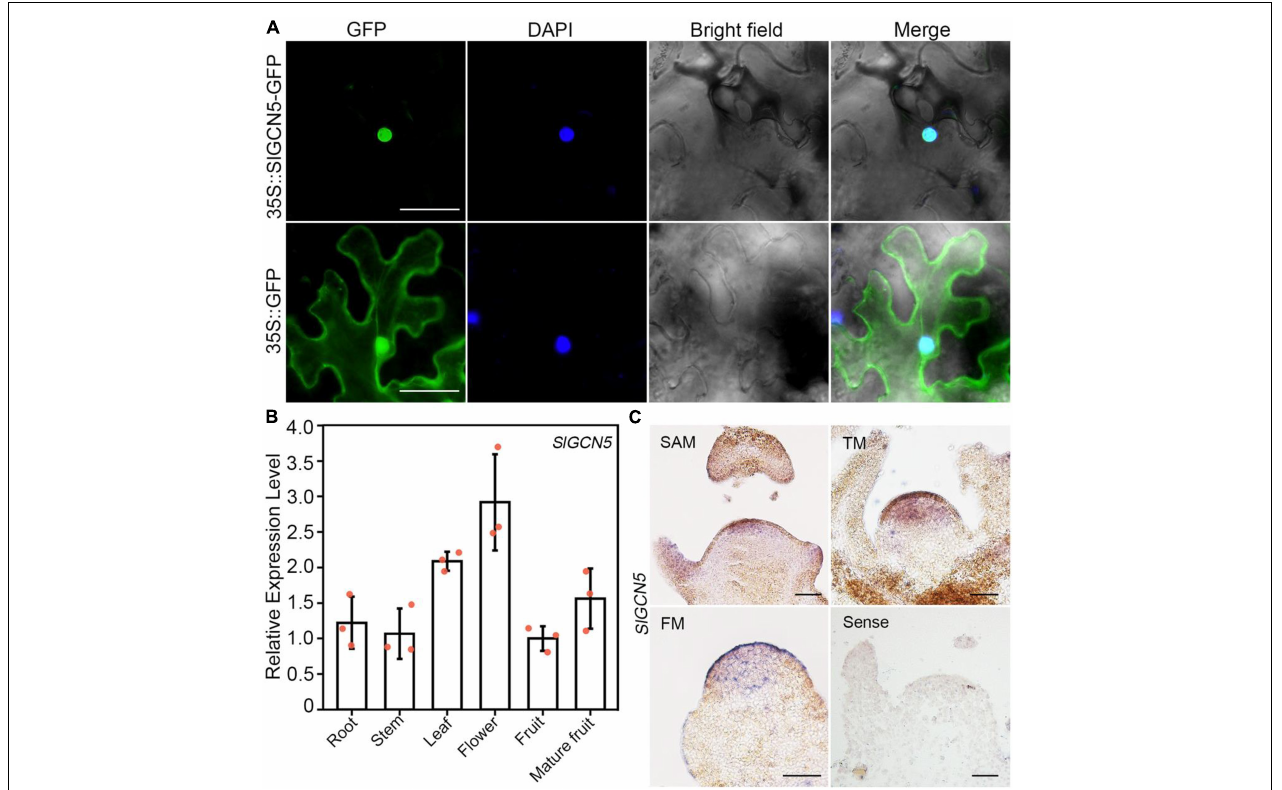
FIGURE 2 | Subcellular localization and gene expression pattern of SlGCN5 . (A) Subcellular localization of SlGCN5 in nuclei. 35S:SlGCN5-GFP represents SlGCN5-GFP fusion protein. 35S:GFP represents the control. Scale bars = 20 µ m. (B) qRT-PCR analysis of SlGCN5 in different tomato organs. SlACTIN served as the internal control. Error bars represent SD of three biological replicates. (C) In situ hybridization of SlGCN5 in SAM, floral transition meristem (TM), and FM, respectively. Scale bars = 50 µ